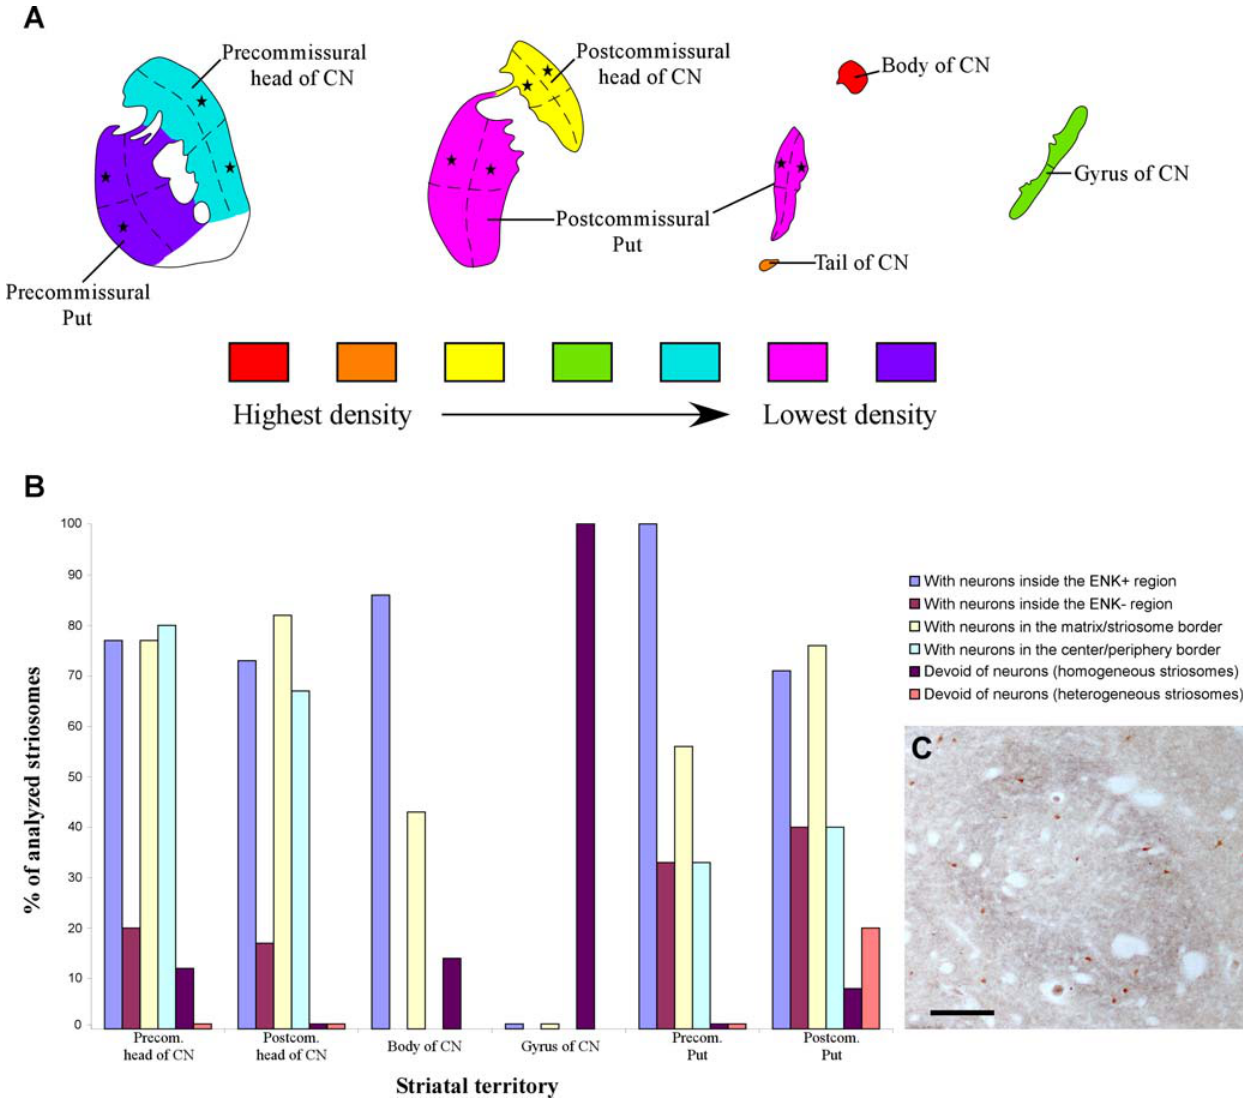
Figure 5. Distribution of ChAT-ir interneurons in the striatum and in its chemical compartments. A , gradients of density of cholinergic interneurons in the various territories of the CN and Put. Within each territory, the density of cholinergic neurons is higher in the quadrants indicated by the asterisks. B , variation in the distribution of the cholinergic interneurons within the striosomes in the various striatal territories. The bar graph illustrates the percentage of striosomes that fulfil the condition indicated by each color in the legend. ENK + region comprises homogeneous striosomes and the periphery of heterogeneous striosomes. n in the X-axis indicates the number of striosomes (homogeneous/heterogeneous) analyzed in each territory. C , color photomicrograph taken from a double ENK/ChAT immunostained section showing one striosome and numerous ChAT-ir neurons in the precommissural head of CN. Observe that the periphery of the striosome is more intensely stained for ENK than its center, and that the ChAT-ir neurons occur within the striosome and in the surrounding matrix. CN, caudate nucleus; ENK, enkephalin; Put, putamen. Scale bar, 250 m m ( C ).